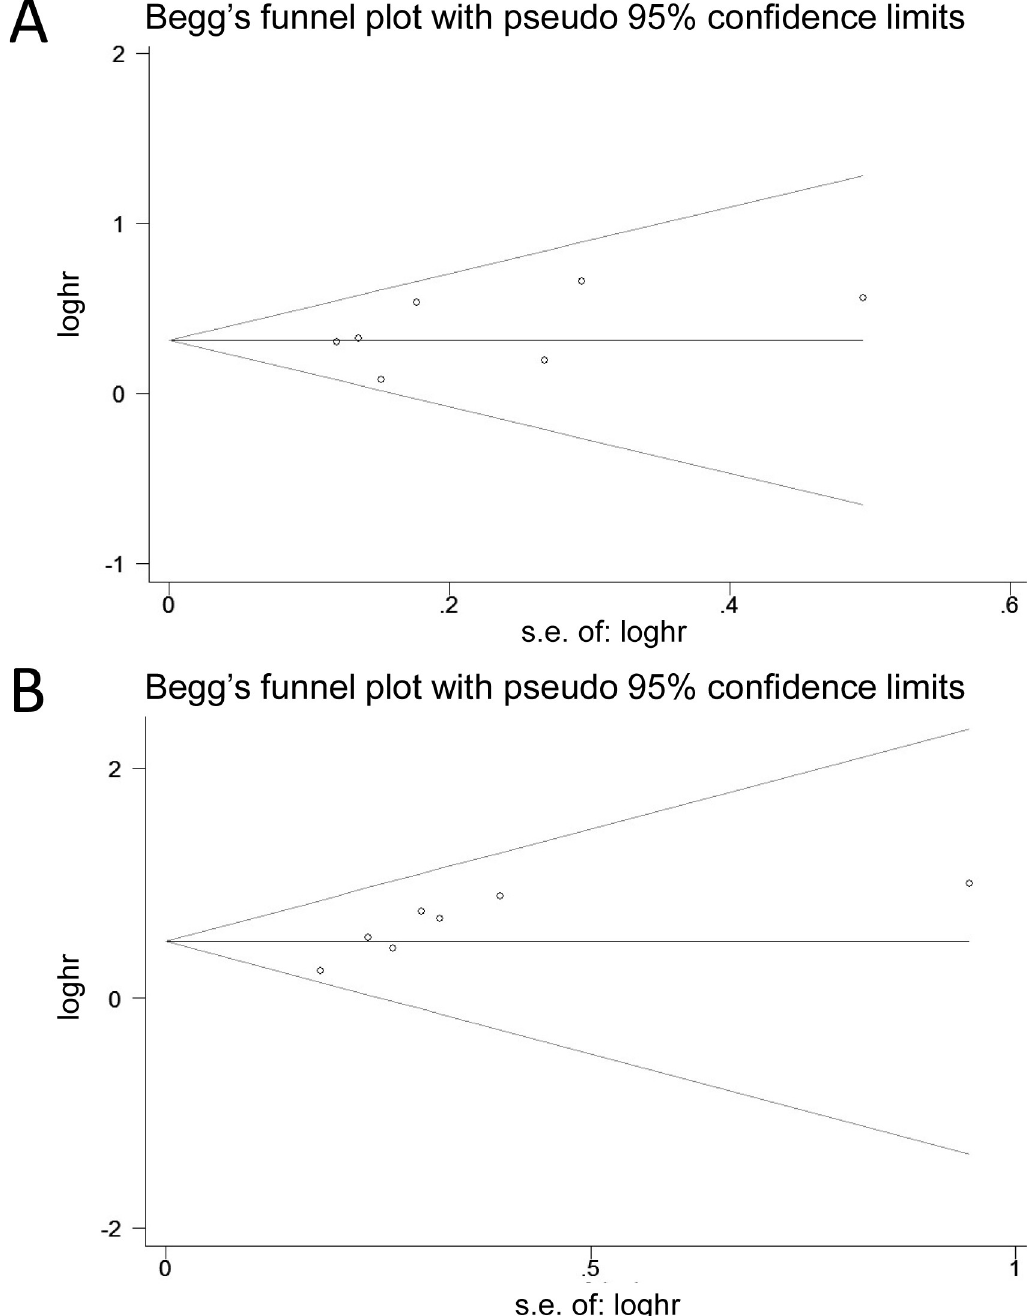
Fig 6. Funnel plots were used to evaluate publication bias on OS and CSS. Begg’s test and Egger’s test were not significant indicating that no significant bias was observed. (A) OS; (B)